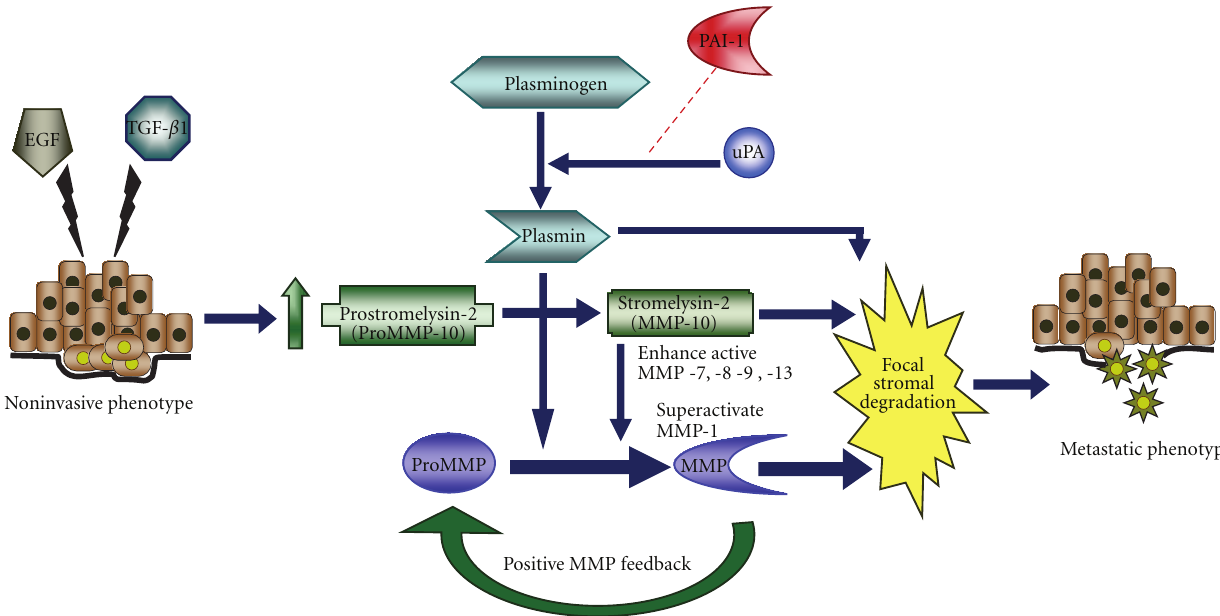
Figure 3: Model of TGF- β 1 + EGF-enhanced plasmin-dependent collagen matrix remodeling and development of an invasive phenotype. In the presence of plasmin, increased MMP-10 levels promote MMP activation creating a proteolytic axis that accelerates collagen degradation through “superactivation” of MMP-1. STAT3 may act as a positive switch in this process, via promotion of EGF-stimulated proMMP-10 expression [23]. Upregulation of PAI-1 in response to TGF- β 1 + EGF may subsequently shift this proteolytic balance, enabling PAI-1 to “titrate” the extent and locale of collagen matrix remodeling to facilitate stromal invasion. Indeed, PAI-1 induction occurs early in this transition and required for stimulated migration and collagen invasion since PAI-1 knockdown (with siRNA constructs) e ff ectively inhibited both events